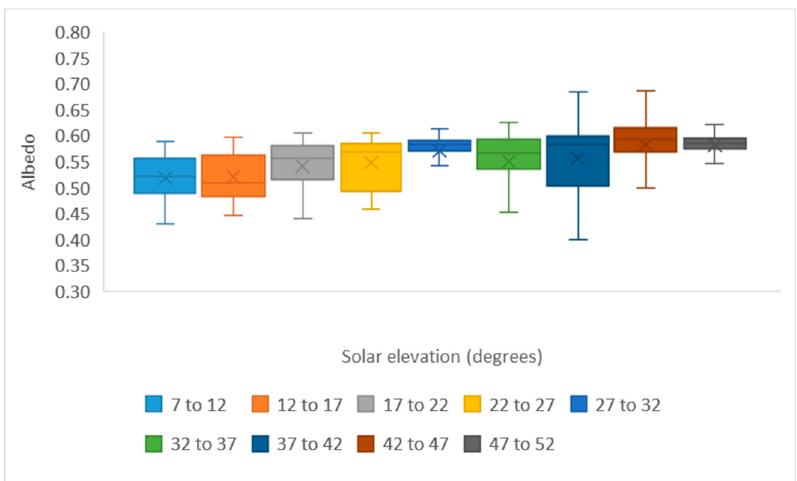
Figure 6. White pebbles’ part-overcast’ (POV) sky condition for albedo variation against solar elevation. The 10 ranges of solar elevation (degrees) are shown in the legend.